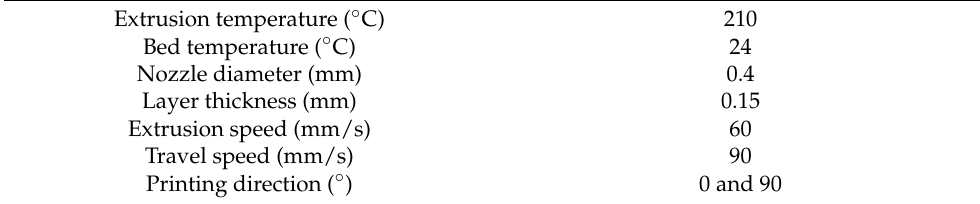
Table 1. Fabrication parameters for 3D printing of scaffold test